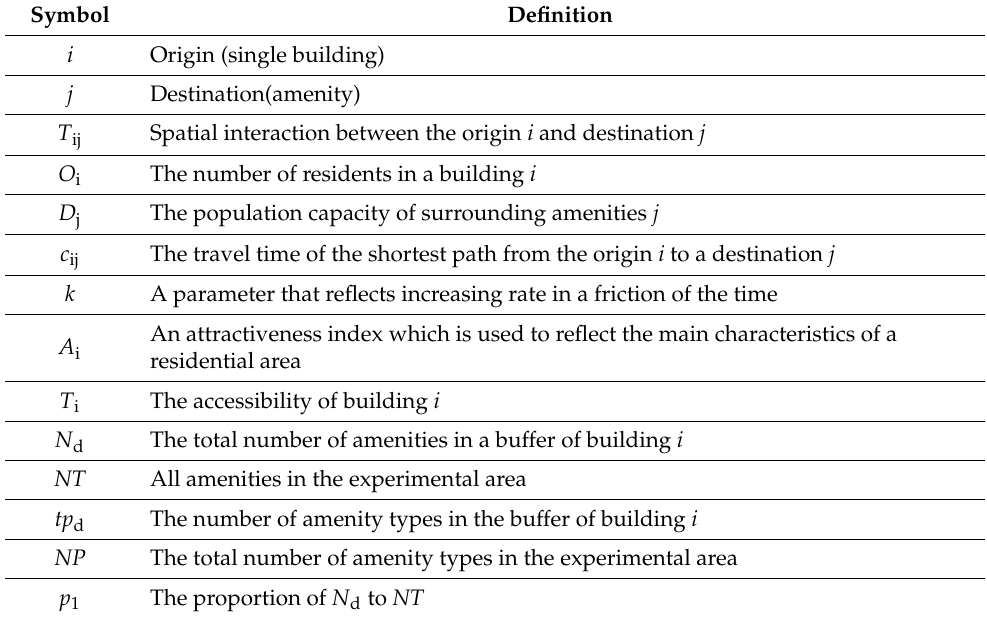
Table 1. The definition of the symbols for accessibility